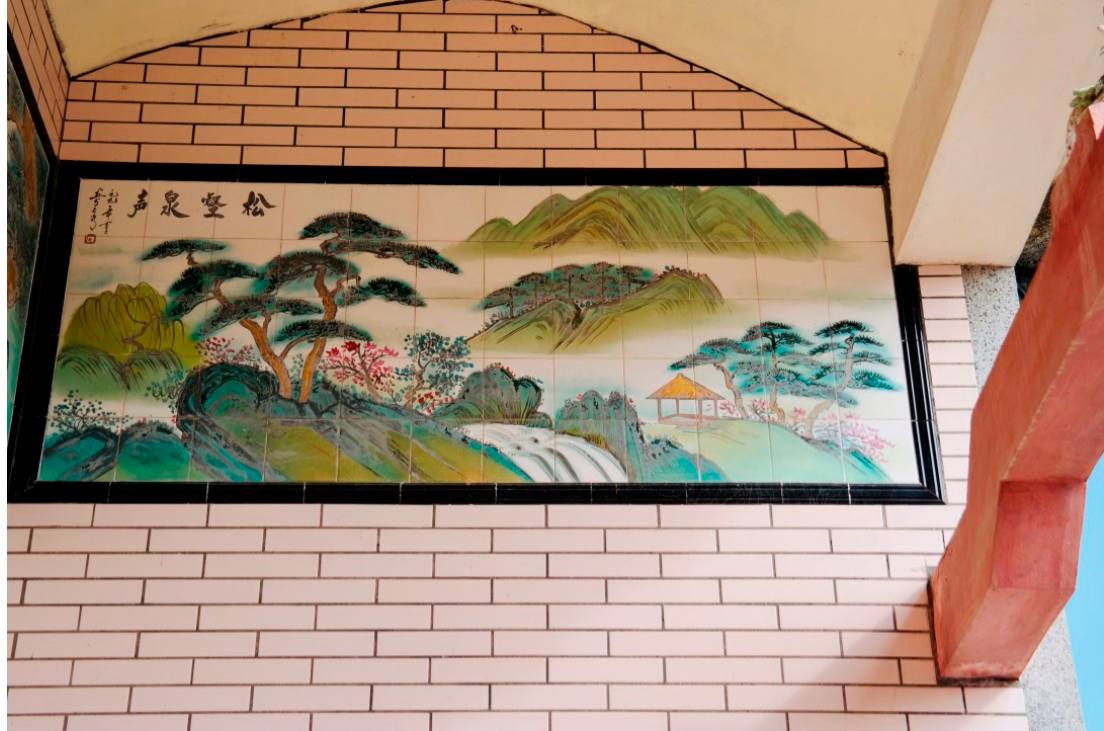
Figure 2. A ceramic tile ‘painting’ replaces a traditional wall painting in the porch of a temple in Sha Tau Kok, in the New Territories of Hong Kong. Photo by Denis Byrne, 2018.